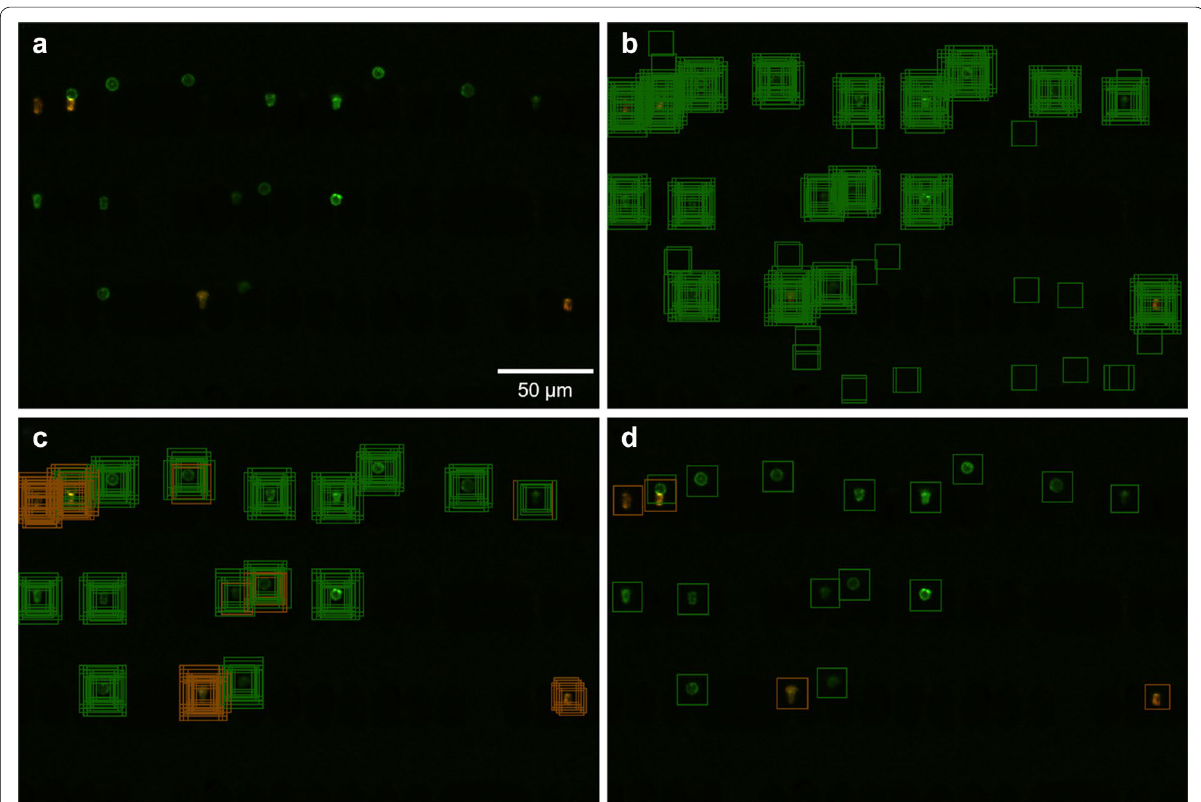
Fig. 6 a Original image. b Green rectangles show preselected windows by the HOG features based SVM classifier, c classification results by AlexCAN; green rectangles show detection windows that are classified as T-cells and orange rectangles show detection windows that are classified as B-cells and d final result after grouping the detection